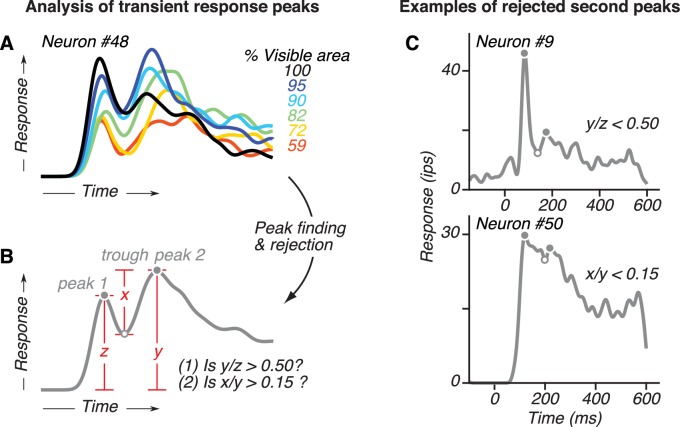
Schematic of the ad hoc peak finding algorithm used.(A) We demonstrate this procedure for the responses of an example V4 neuron with two peaks (same data as in Figure 4B). (B) We constructed an average PSTH from the individual PSTHs to each occlusion level (% visible area <100) that evoked strong responses. We then used a zero-crossing algorithm to identify local peaks (filled circles) and an intervening trough (open circles) in the average PSTH, and within 300 ms of test stimulus onset. Small peaks (<50% of the initial transient response; that is y/z < 0.5) and small trough-to-peak modulations (<15% of the local peak magnitude, that is x/y < 0.15) were rejected. For each putative second peak that met these criteria, we asked whether there was a statistically significant increase in response relative to the preceding trough. To do this, we conducted a paired t Test between the average activity in a 30 ms window centered on the putative second peak and on the preceding trough (p<0.05, Bonferroni corrected). For this example neuron, there was one peak (labeled peak 2) that passed the criteria and t Test. (D) Example of neuronal responses where the local maxima in the average PSTH were rejected as candidates for second response peak because the candidate peak was too small relative to the first peak (top, y/z < 0.5) or because the trough-to-peak modulation was too small (bottom, x/y < 0.15). See B for schematic representations of x, y, and z.